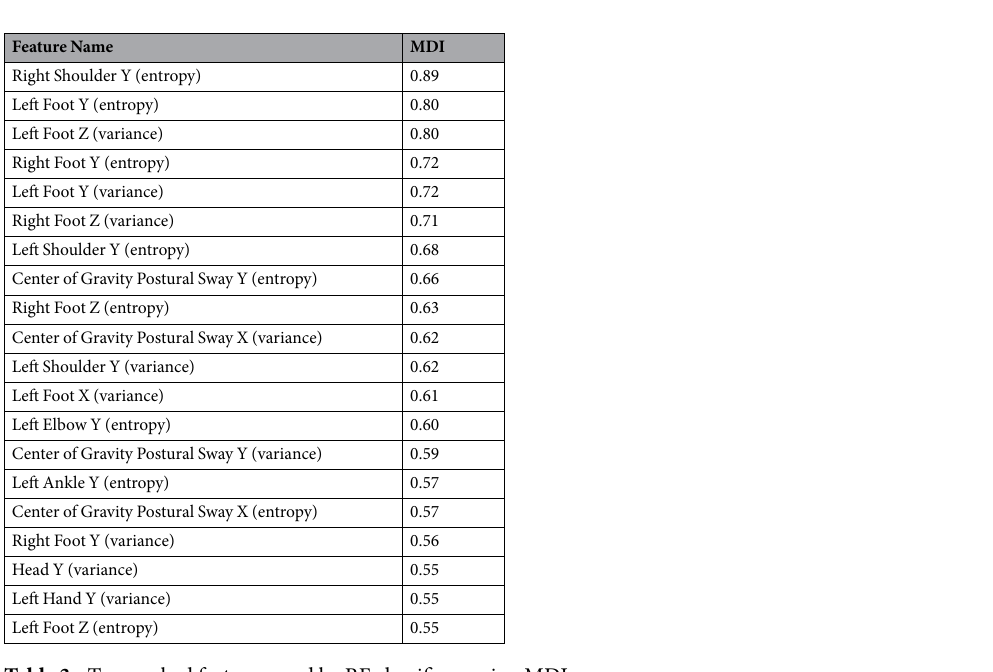
Figure 2. Correlation analysis of the distance from classification boundary vs. ( A ) age, ( B ) overall motor performance and ( C ) social responsiveness symptoms.